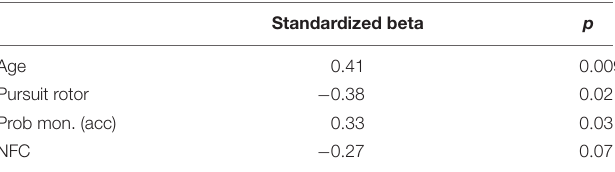
TABLE 2 | Standardized coefficients for stepwise forward regression predicting response times to loss of control.